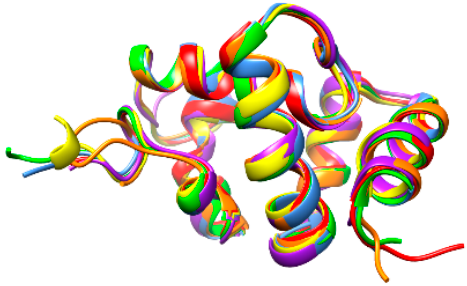
Figure 3. A. Superposition of the ribbon diagrams of chemosensory proteins from Apis mellifera (blue), Bombyx mori (red), Bactrocera dorsalis (green), Locusta migratoria (purple), Schistocerca gregaria (yellow) and Tenebrio molitor (orange).